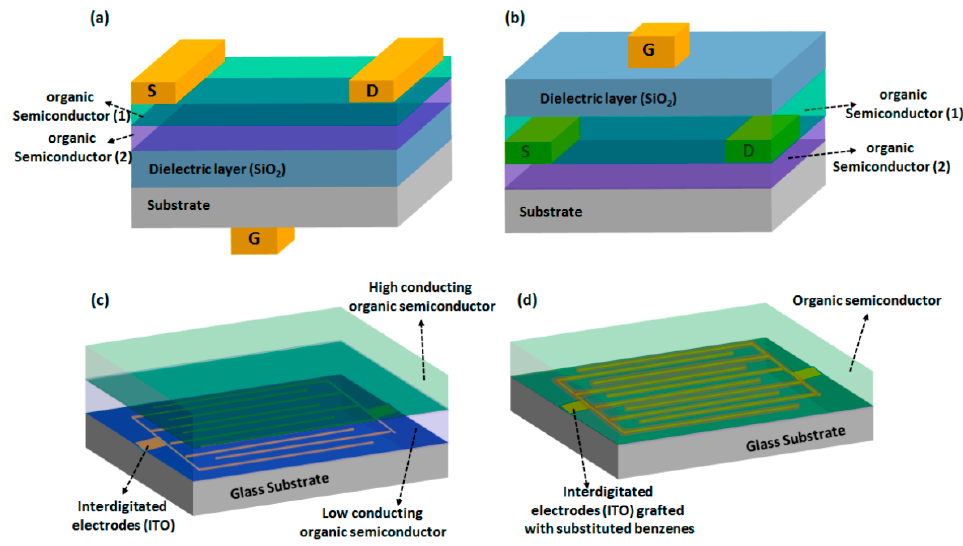
Figure 2. Scheme of OFET device designs in suspended gate ( a ) and top gate ( b ) configuration. Scheme of MSDI ( c ) and double lateral heterojunction ( d ) device [75].